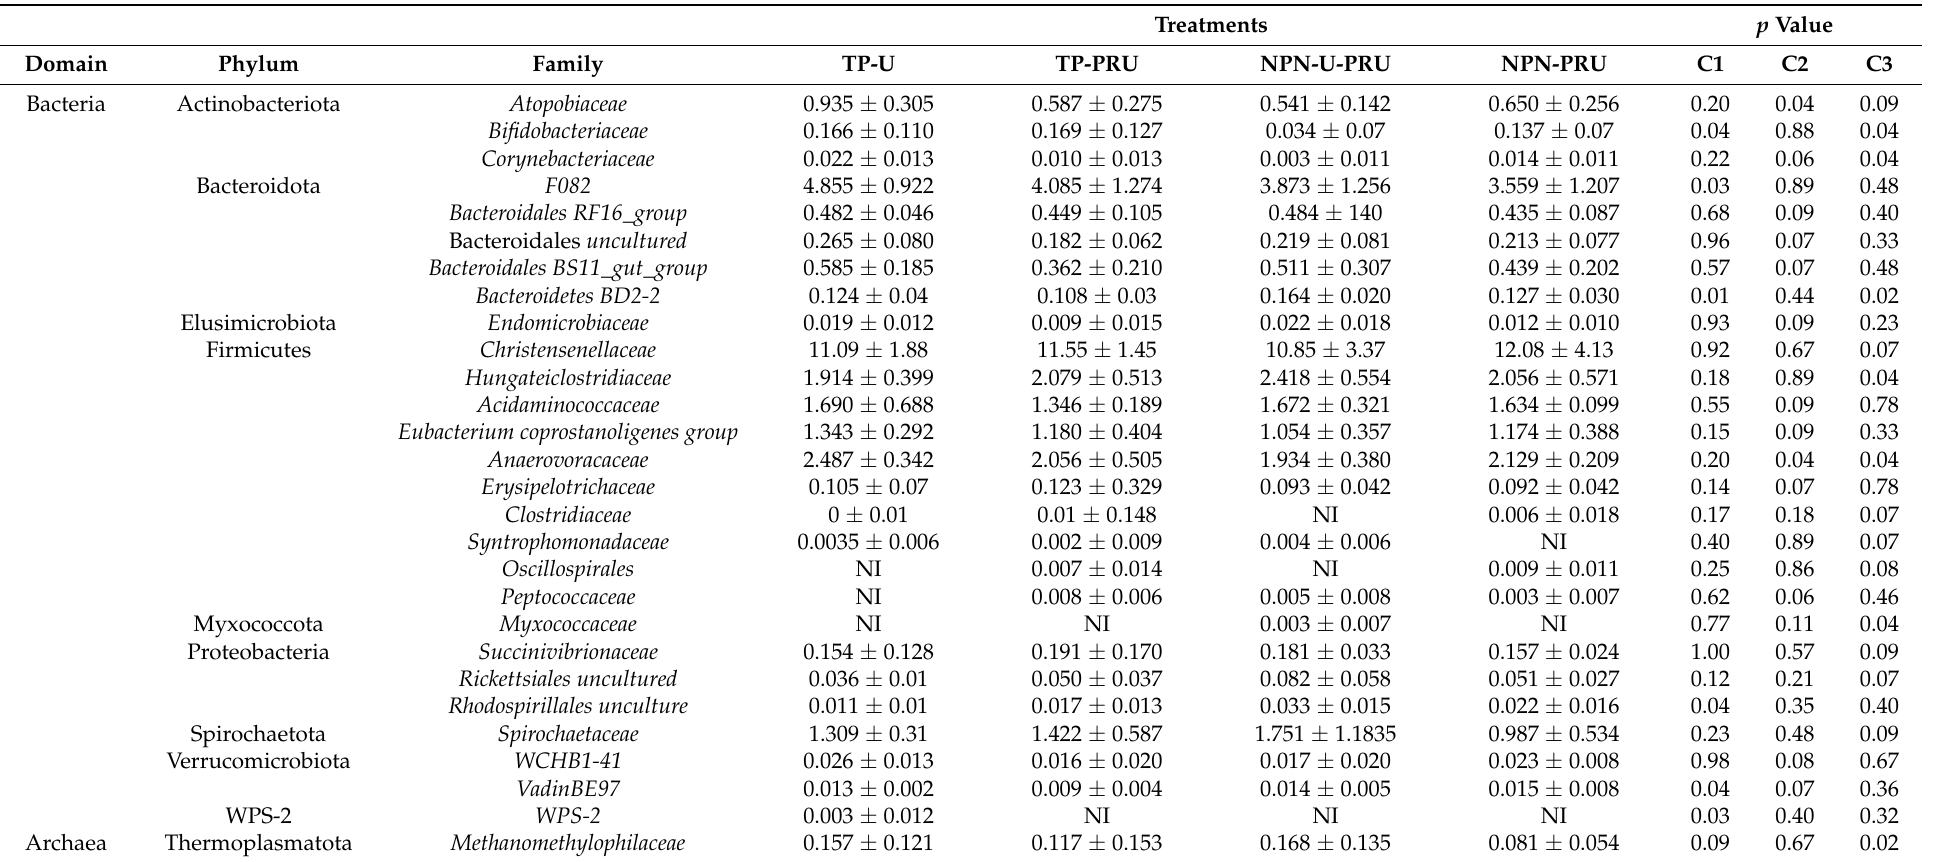
Table 6. Median and interquartile variation of relative abundance of the family in Nellore steers receiving supplements containing conventional urea and post-ruminal urea during the seasonal period